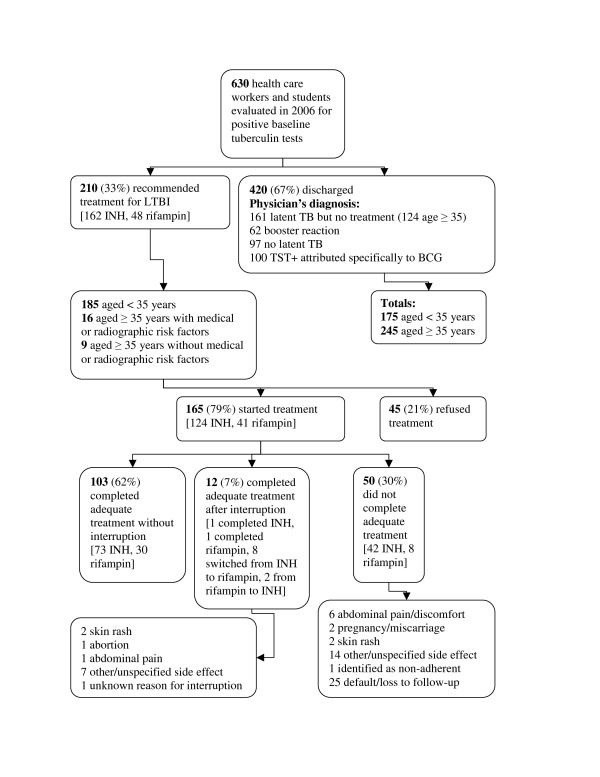
Health care workers and students evaluated at the Montreal Chest Institute, 2006. Flow chart of health care workers and students evaluated at the Montreal Chest Institute for positive baseline tuberculin tests, 2006. Abbreviations: LTBI = latent tuberculosis infection, INH = isoniazid, TST = tuberculin skin test, BCG = Bacille Calmette-Guérin.